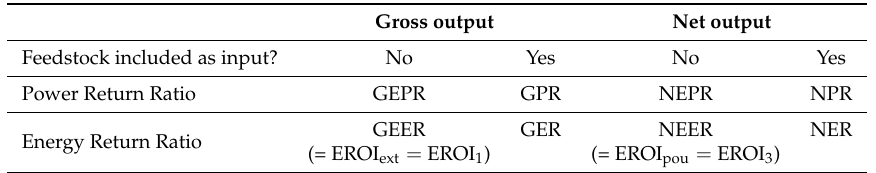
Table 1. A summary of the categorization of the several energy return ratios (ERRs) and power return ratios (PRRs). For reference, EROI = energy return on (energy) invested; EROI subscripts are: ext = extraction (or Boundary 1), pou = point of use (or Boundary 3)